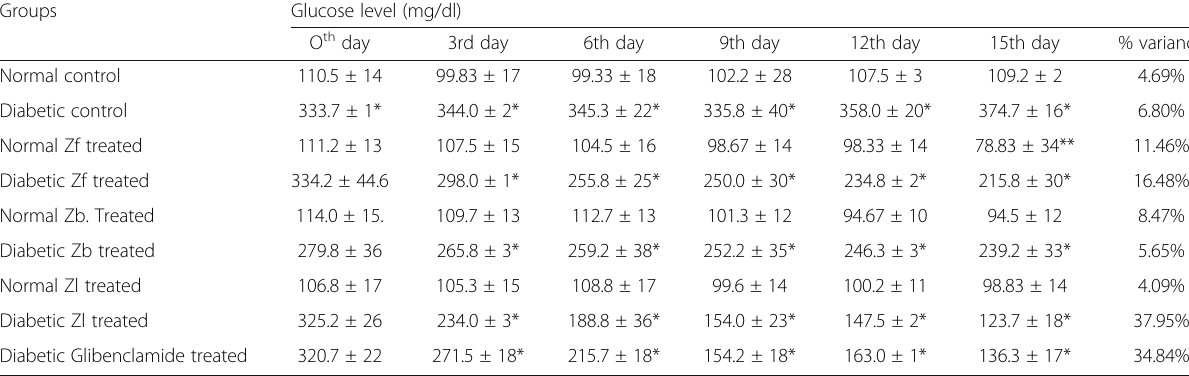
Table 2 Effect of extracts of Zanthoxylum armatum and standard drug Glibenclamide on glucose level of normal and alloxan induced diabetic mice Groups